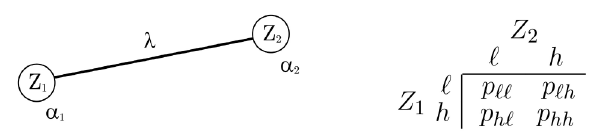
FIGURE 2 | The n 2 case with variables Z 1 and Z 2 . (Left) The graph, = showing the model parameters. (Right) The joint PMF.